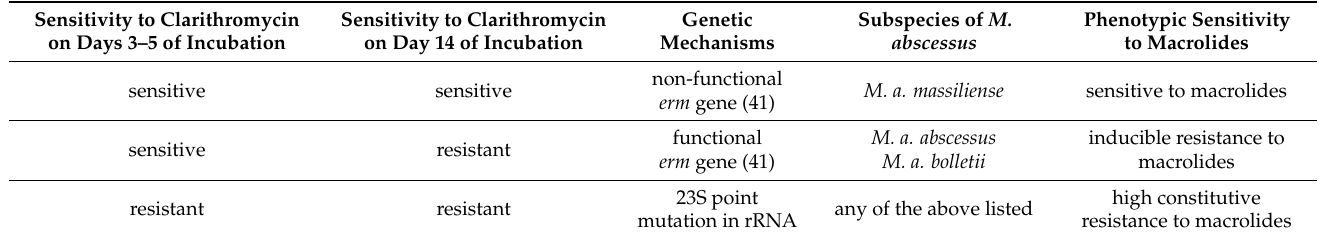
Table 10. Interpretation of AST results for M. abscessus complex and